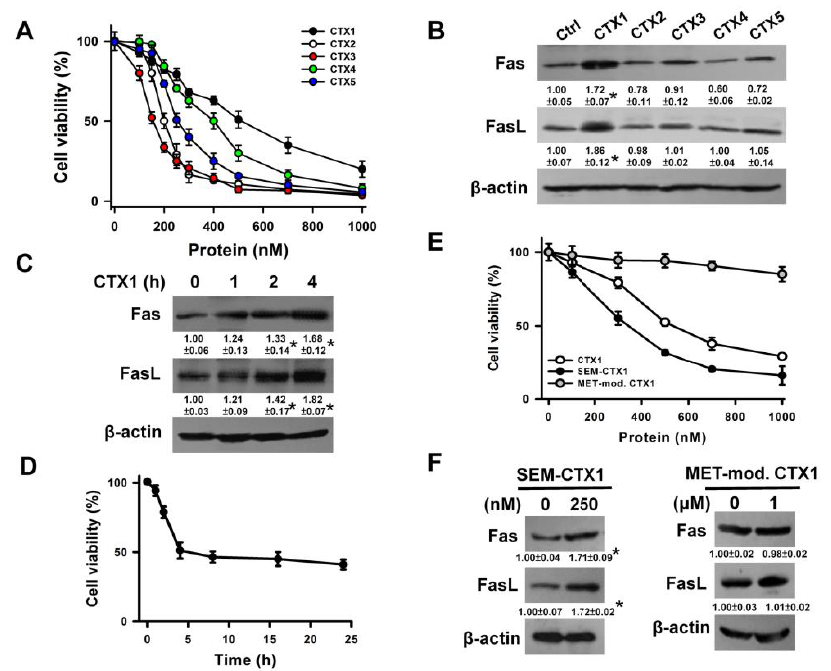
Figure 1. Upregulation of Fas and FasL in CTX1-treated U937 cells. ( A ) CTX1, CTX2, CTX3, CTX4, and CTX5 induced cell death in a concentration-dependent manner. U937 cells were incubated with varying concentrations of CTXs for 4 h. Cell viability was determined by MTT assay. Results are expressed as the percentage of cell proliferation relative to the control. Each value is the mean ± SD of triplicate determinations. ( B ) Effect of CTXs on Fas and FasL protein expression. U937 cells were treated with 500 nM CTX1, 200 nM CTX2, 150 nM CTX3, 400 nM CTX4, and 250 nM CTX5 for 4 h (* p < 0.05, CTX1-treated cells compared to untreated control cells). ( C ) CTX1 treatment increased Fas and FasL protein expression in a time-dependent manner. U937 cells were treated with 500 nM CTX1 for indicated time periods (* p < 0.05, CTX1-treated cells compared to untreated control cells). ( D ) CTX1 induced death of U937 cells in a time-dependent manner. U937 cells were treated with 500 nM CTX1 for indicated time periods. ( E ) Effect of SEM-CTX1 and Met-modified CTX1 on the viability of U937 cells. U937 cells were incubated with varying concentrations of SEM-CTX1 and Met-modified CTX1 for 4 h. ( F ) Effect of SEM-CTX1 and Met-modified CTX1 on Fas and FasL expression. U937 cells were incubated with indicated SEM-CTX1 and Met-modified CTX1 concentration for 4 h (* p < 0.05, SEM-CTX1-treated cells compared to untreated control cells).